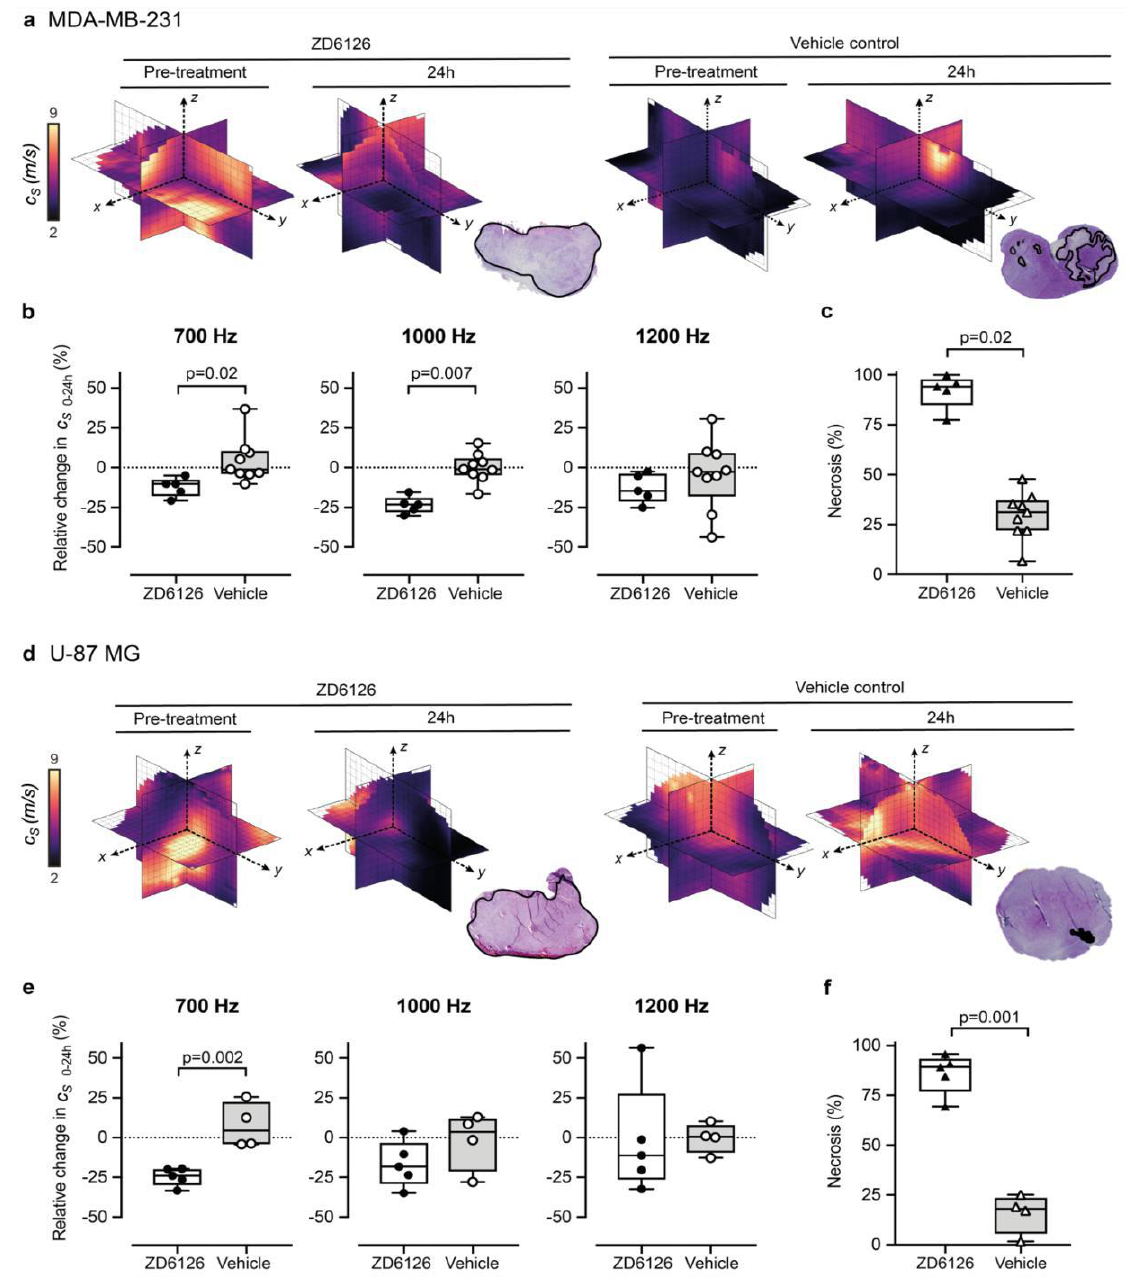
Figure 3. 3D-vibrational shear wave elastography is sensitive to ZD6126-induced tissue damage. ( a and b ) show MDA-MB-231 human triple-negative breast cancer, ( d and e ) show U-87 MG human glioblastoma tumours. Representative 3D-VSWE derived parametric maps of c s show a marked and global decrease in c s , 24 h following treatment with ZD6126 in both models, corroborated by the presence of extensive regions of haemorrhagic necrosis (outlined in black) visible on H&E-stained slide in stark contrast to the presence of a large area of viable tumour with a varied number of necrotic foci in the vehicle-control cohort. ( b and e ) show the quantitative analysis of the relative changes in spatial-median c s values acquired at different frequencies, with either 200 mg/kg ZD6126 or vehicle, in both models (box plots show mean ± SD; Mann-Whitney test with 5% significant level). ( c) and ( f) show the quantitative analysis of the extent of necrosis quantified on the H&E-stained section.